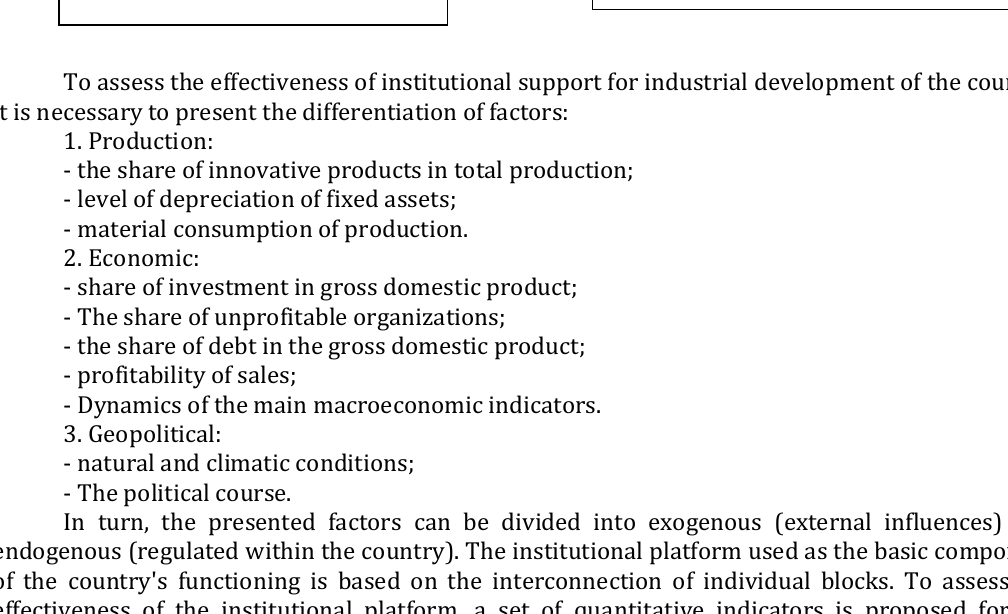
Table 2: Block-indicator structure of the institutional platform for industrial development Block Monitoring